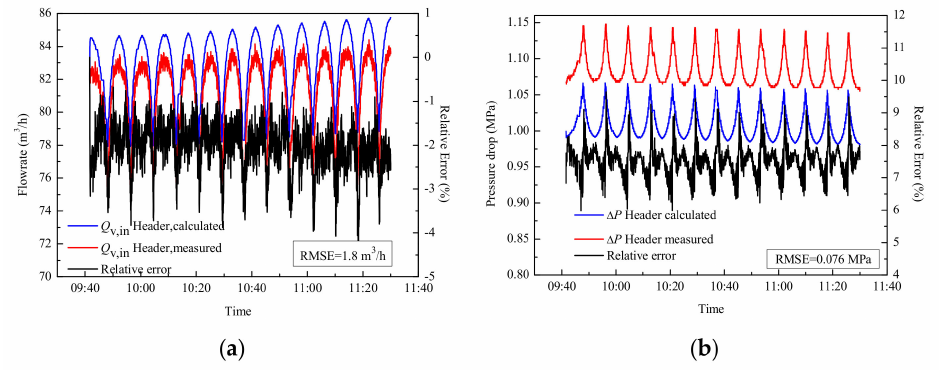
Figure 9. Compared results between calculated and measured data in a cold test for the ( a ) header inlet flow rate, and ( b ) header pressure drop.